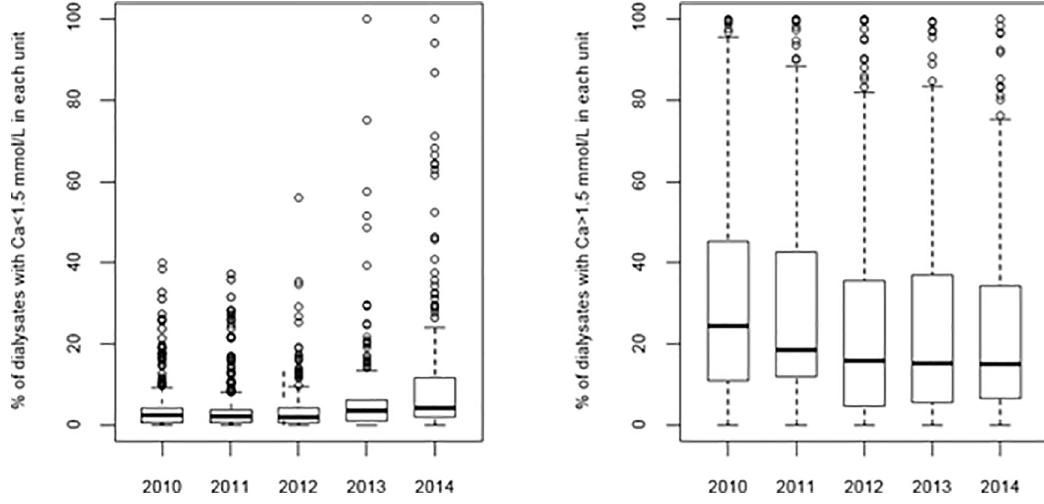
Fig 3. Boxplots of the dialysis units’ percentage use of dialysate calcium concentrations between 2010 and 2014.